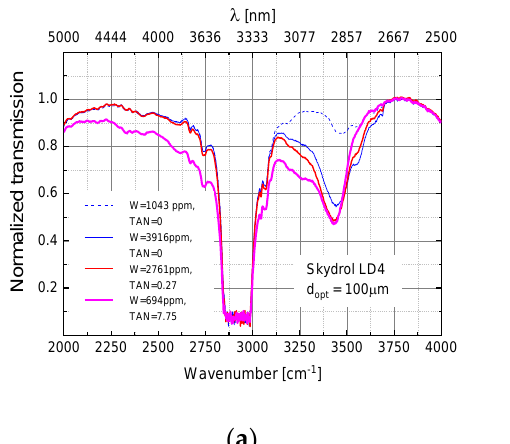
H 2 O bend + libration Figure 4. Difference spectra as obtained on Skydrol LD4 after controlled contamination with water (top row) and after water contamination and molecular fragmentation (bottom row). The water-contaminated samples contained up to 1.5% H 2 O, while the degraded ones had TAN-values between 1–3 mg KOH/g as determined by conventional titration. The spectra of the thermally degraded samples were offset by one unit of normalized absorption towards ΔT norm = −1 for reasons of clarity of presentation. 4. MIR Monitoring of Aviation Hydraulic Fluids The most straight-forward way of arriving at an opto-chemical sensor system is concentrating, firstly, on those strong ground state absorptions which derive from vibrations of O-H groups which are either parts of dissolved water or split-off alcohols and, secondly, on those that derive from phosphate cores [16] which had lost their hydrocarbon side-groups. As shown in Figure 5a, water contamination leads to an increase in the O-H absorption strength around 3500 cm −1 . Upon fluid degradation, the O-H absorption feature shifts towards lower wavenumbers around 3300 cm −1 as O-H groups, initially bound to dissolved water, become bound to alcohols which had been split off from their phosphate cores. As long as the remaining partial